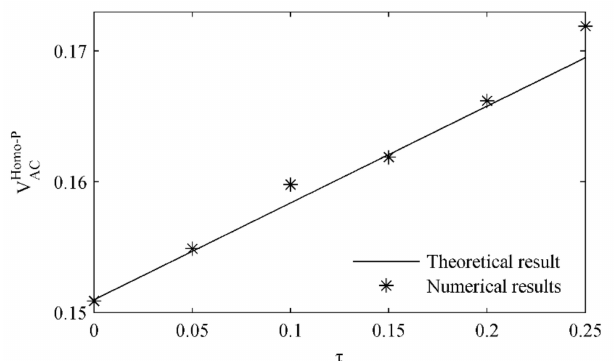
Figure 9. Variation of V AC threshold for homoclinic bifurcation with τ when g p = 0.2.